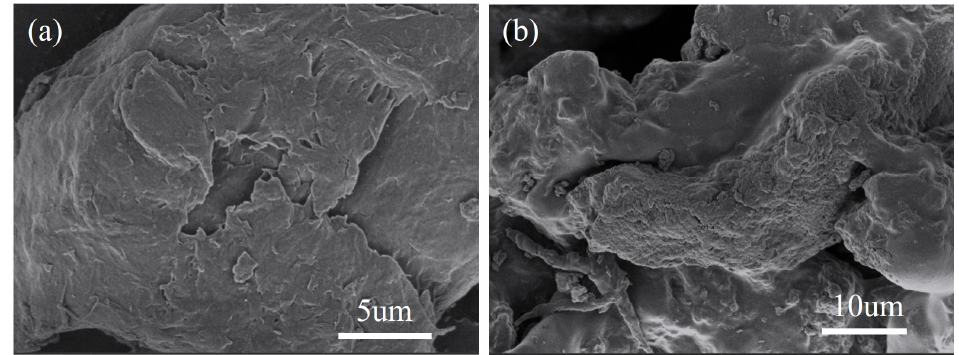
Figure 1. SEM images (( a ): CS, ( b ): PYCS).